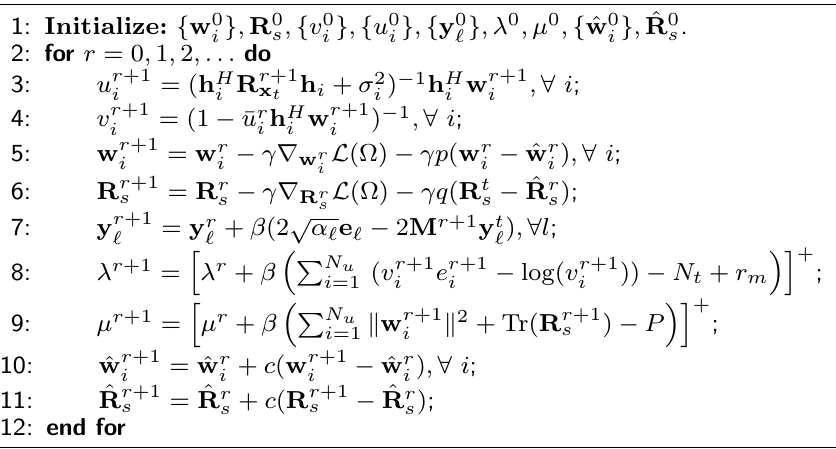
Algorithm 2 Proposed FP-SGDA